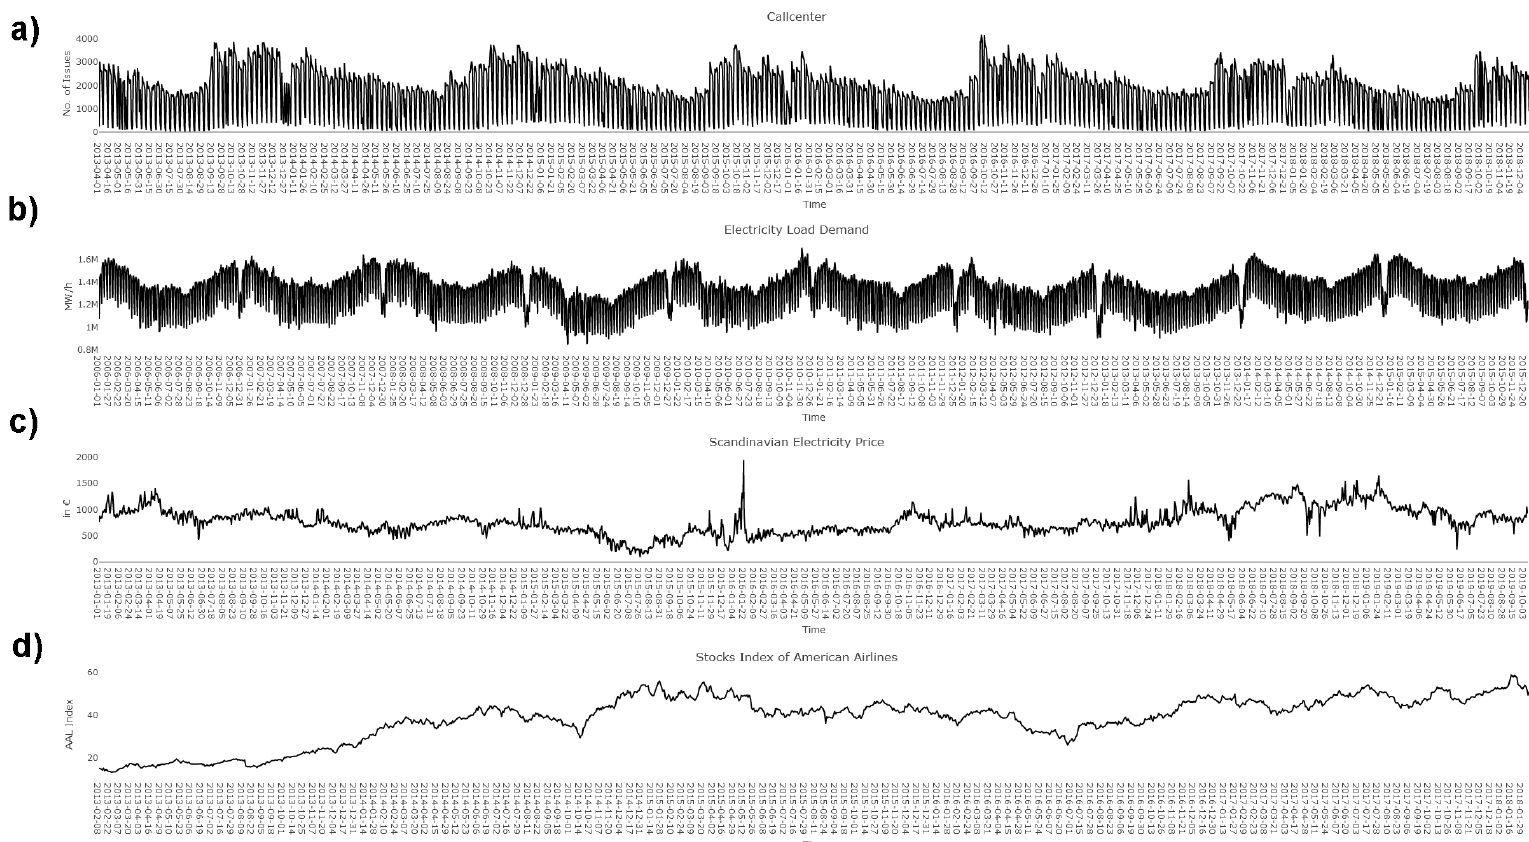
Figure A1. Data visualization of the four time series used in this work with the measurement unit: ( a ) Callcenter (number of issues per day), ( b ) Electricity (daily electricity demand in Germany MW/H), ( c ) Prices (daily system price in e ) and ( d ) Stocks (American Airline Index taken from the